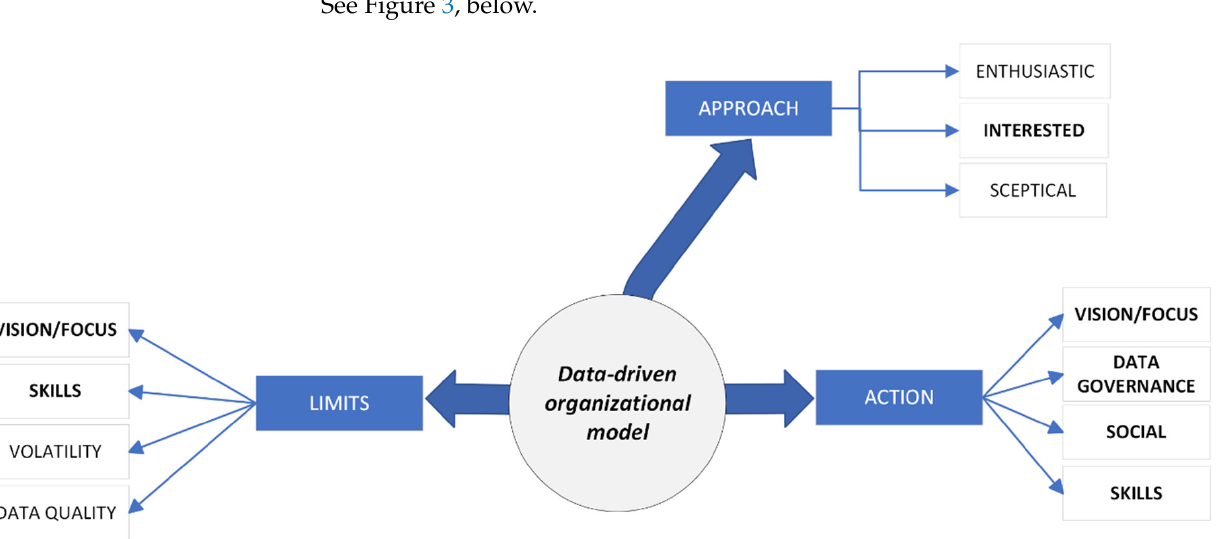
Figure 4. The emergent theoretical model.